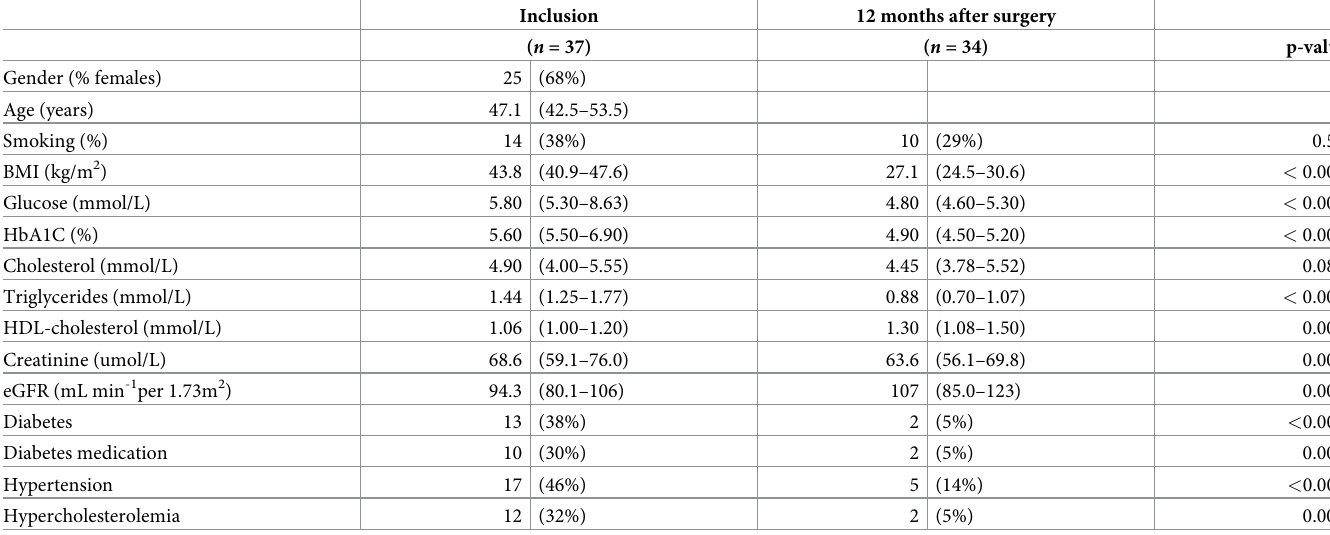
Table 3. Patient characteristics at inclusion and after bariatric surgery.